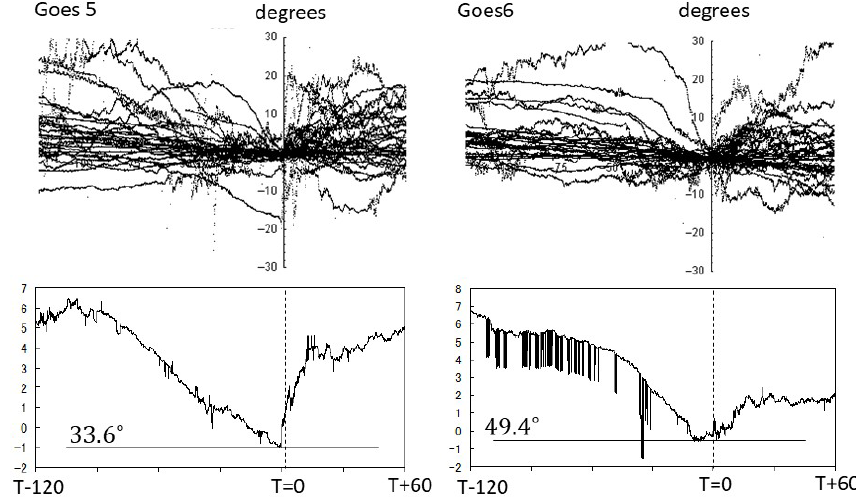
Figure 1. Inclination angles in degrees measured positive northward from the V – D plane from 120min prior to the Pi2 onset ( T − 120) and to 60min after the Pi2 onset ( T + 60) reproduced from Saka et al. (2010). Magnetometer data of Goes 5/6 were represented in HVD coordinates: H is positive northward parallel to dipole axis, V is radial outward, and D is dipole east. Epoch superposition of 30 Pi2 events and mean angles calculated from them are plotted in top and in lower panels, respectively. Mean inclination angle at 2min before the initial peak of Pi2 amplitudes ( T = 0) was 33.6 ◦ for G5 and 49.4 ◦ for G6 in dipole coordinate. Dipolarization was step-like at Goes5, while at Goes6 it was composed of dipolarization pulses. The average satellite latitudes estimated by T89 model were 10.3 and 7.9 ◦ N for Goes5 and Goes6,